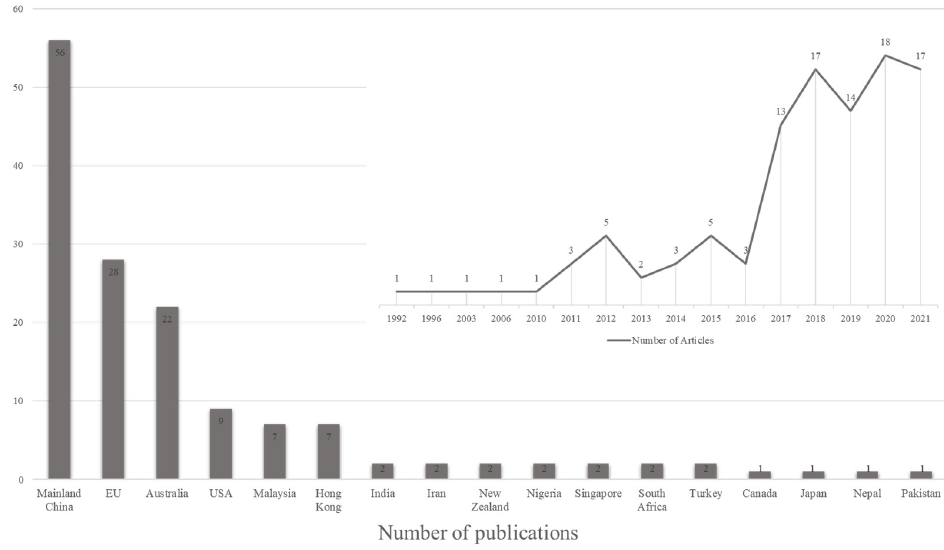
Figure 1. Annual publications trend and Geospatial distribution of CIP articles .